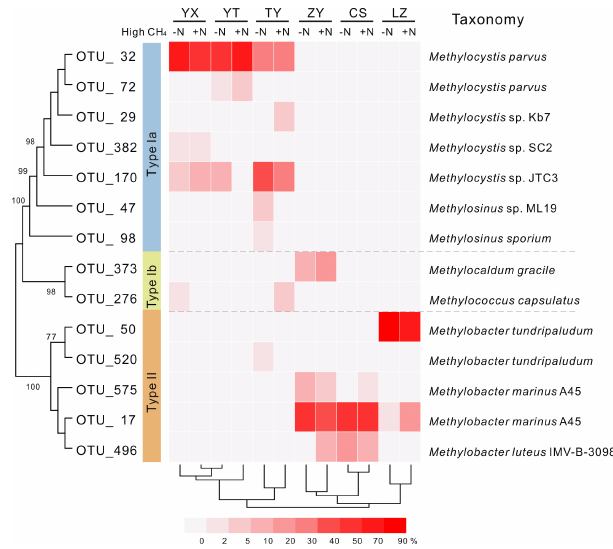
Figure 3. Heat map of relative abundances of major 13 C-labeled methanotrophic OTUs based on pmoA gene sequencing. “ − N” and “ + N” indicate 13 CH 4 -amended microcosms without and with N fertilization, respectively. Hierarchical clustering of samples was performed, and phylogenetic relations between different OTUs are shown by the topology, with bootstrap values > 60% indicated at branch nodes. Each OTU representative sequence is taxonomically annotated to a defined strain from GenBank with the closest phylo- genetic relation.